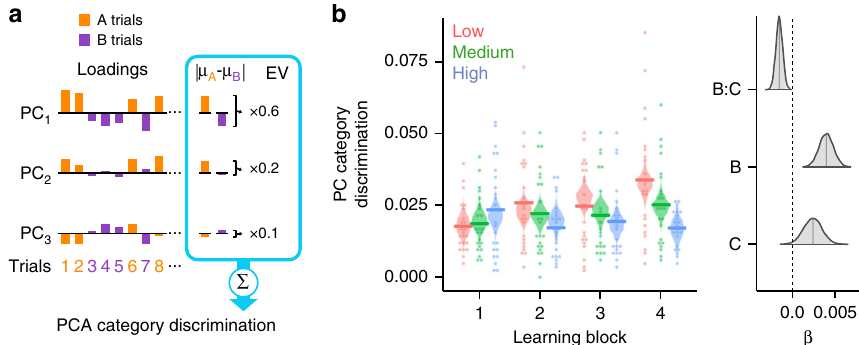
Fig. 4 Category discrimination in neural compression ( N = 23). a Category discrimination in PCA neural compression was indexed by the difference in loadings for the two categories. The absolute difference between the average loadings for category A trials (orange) and B trials (purple) for each PC were weighted by the PC ’ s explained variance ratio and summed. b Category discrimination increased across learning blocks with the highest discrimination for low followed by medium and high problem complexity. Points depict individual participants, horizontal lines are group averages, and violin plots depict the distribution of posterior predictions from the Bayesian-estimated linear regression. The right panel depicts posterior distributions of regression coef fi cients for learning block ( b ), complexity ( c ), and their interaction ( b : c ). The shaded region within the distributions marks the 95%